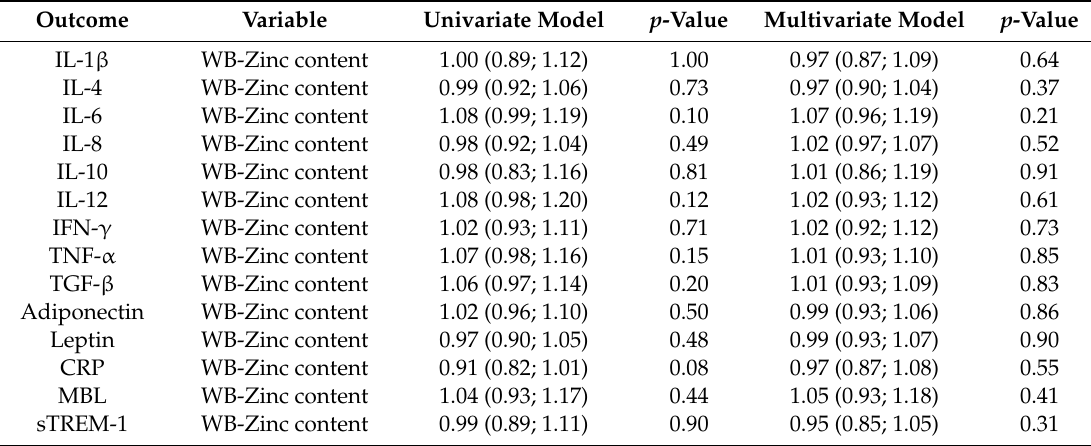
Table 2. Relative change in mean neonatal levels of cytokines, adipokines and other proteins involved in the immune response with 95% confidence bands linked with every doubling in neonatal whole blood zinc content—results from models without correction for multiple testing.